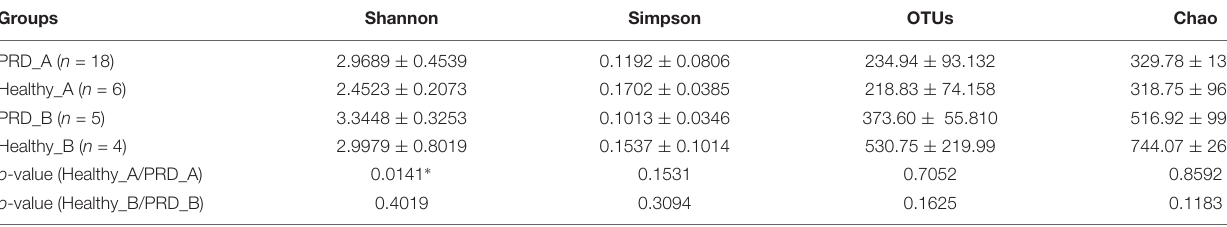
TABLE 1 | Bacterial diversity indices (Shannon, Simpson, Chao, and OTUs) are presented as the mean ± standard deviation. Groups Shannon Simpson